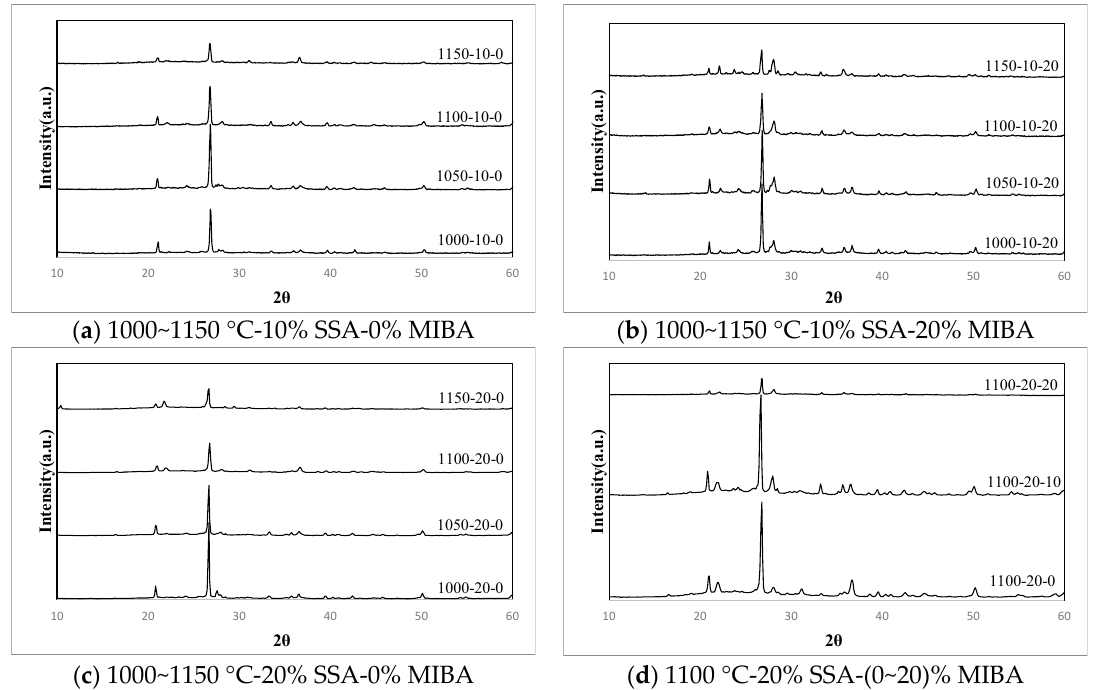
Figure 16. XRD diffractograms. ( a ) 1000~1150 ◦ C-10% SSA-0% MIBA; ( b ) 1000~1150 ◦ C-10% SSA-20% MIBA; ( c ) 1000~1150 ◦ C- 20% SSA-0% MIBA; ( d ) 1100 ◦ C-20% SSA-(0~20)